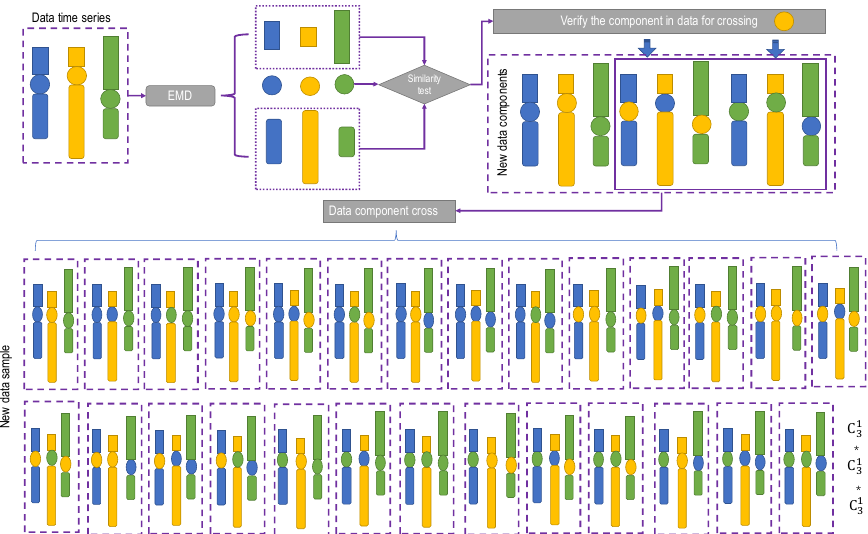
Figure 2. Data component cross procedure. In the figure, the rectangle, rounded rectangle, and circle represent various intrinsic mode functions (IMFs) respectively (IMF1, IMF2, IMF3, ….) decomposed by empirical mode decomposition (EMD) in each segment. The colors indicate the different segments. The cross is implemented between the same IMF components of two segments meeting the similarity